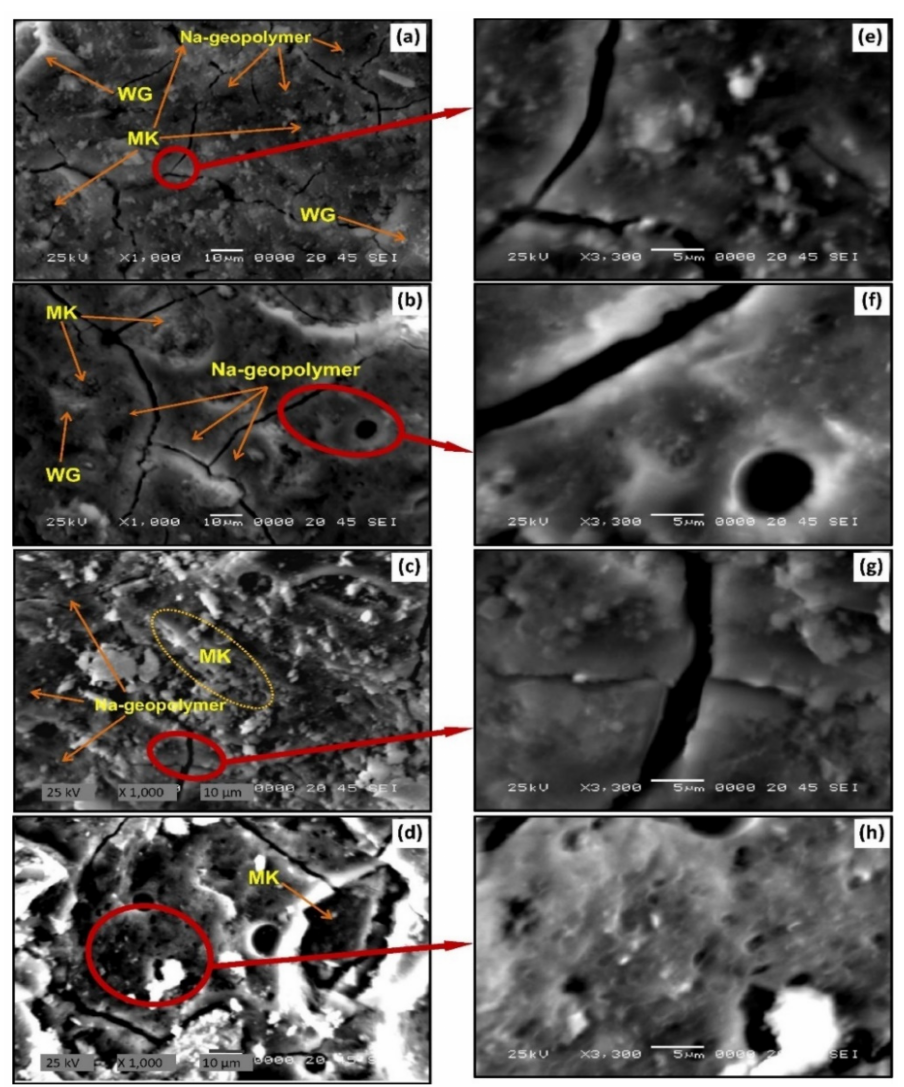
Figure 21. SEM micrographs (1000 × ; 10 µ m) of WG/MK-based geopolymers cured at ( a ) 25, ( b ) 40, ( c ) 60, and ( d ) 80 ◦ C. Red circles in ( a – d ) are magnified (3300 × ; 10 µ m) into ( e – h ), respectively